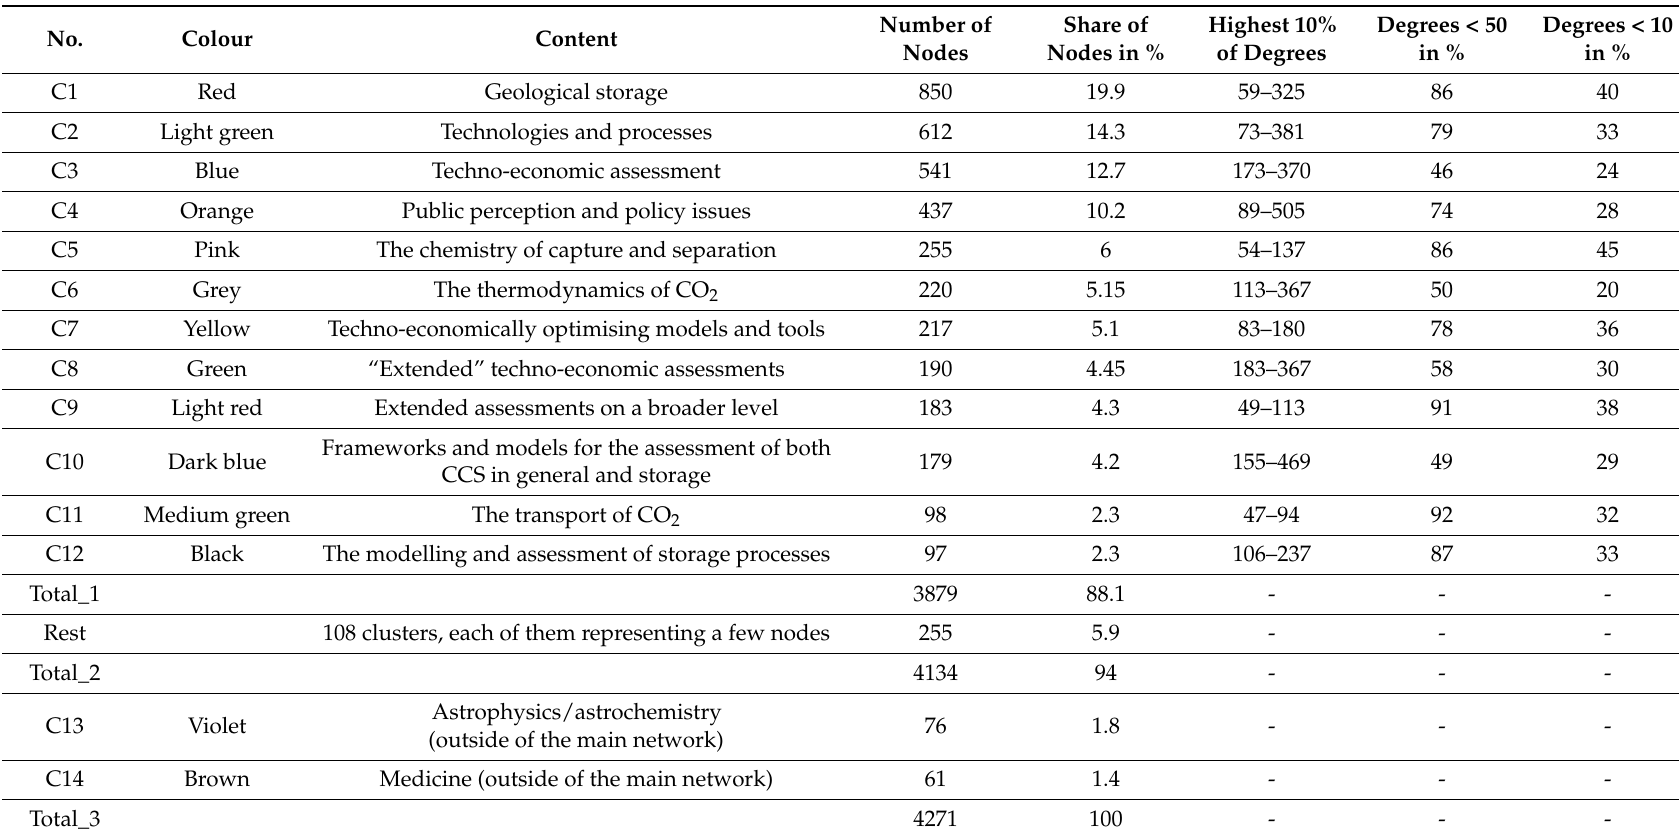
Table A1. Topics and data of each base paper network